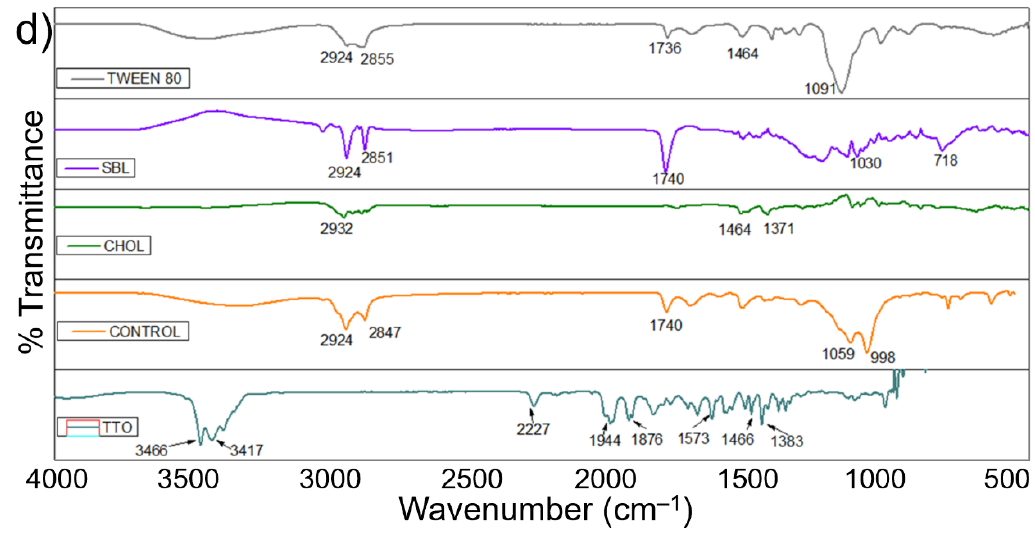
Figure 2. ATR-FTIR studies of CEO and TTO nanoliposomes ( a ) IR spectra of CEO nanoliposomes, ( b ) IR spectra of SBL, CHOL, Tween 80 ® , CEO and control, ( c ) IR spectra of TTO nanoliposomes, and ( d ) IR spectra of SBL, CHOL, Tween 80 ® , TTO, and control.